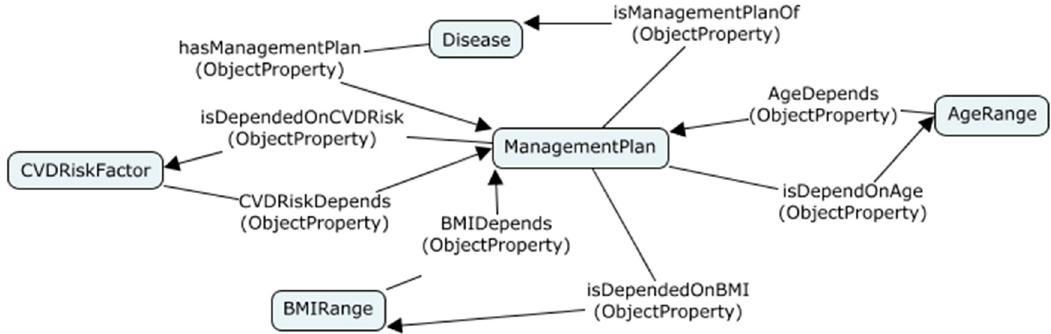
Figure 6. Applying n-ary design pattern 2 .